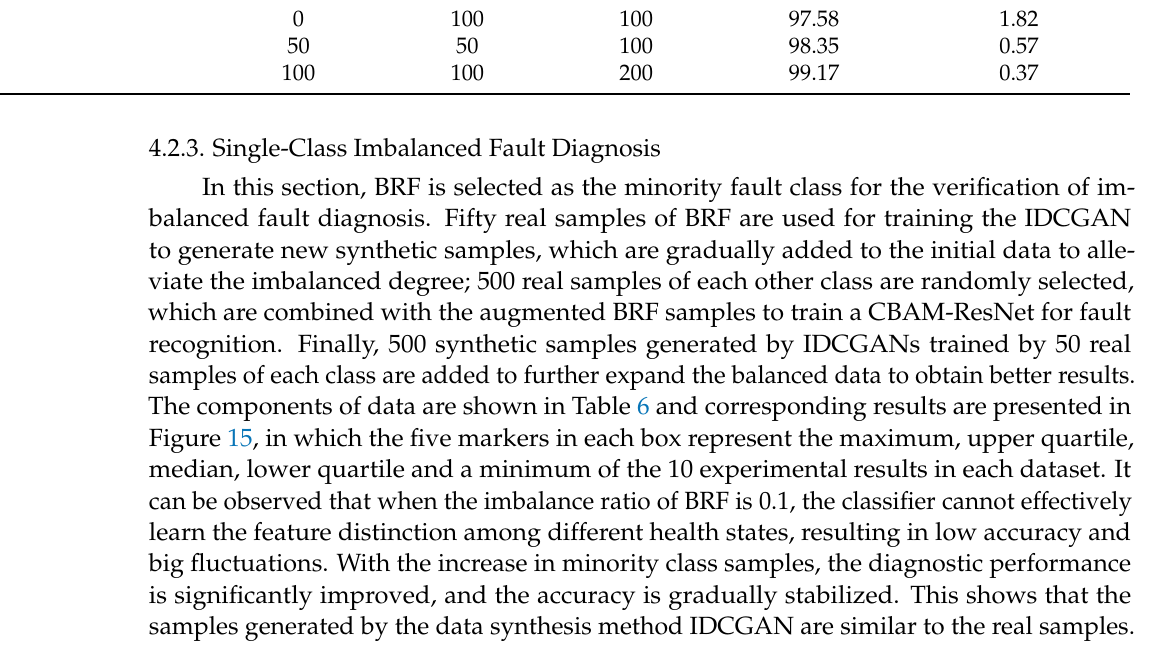
Table 6. Experiment components with different amounts of generated